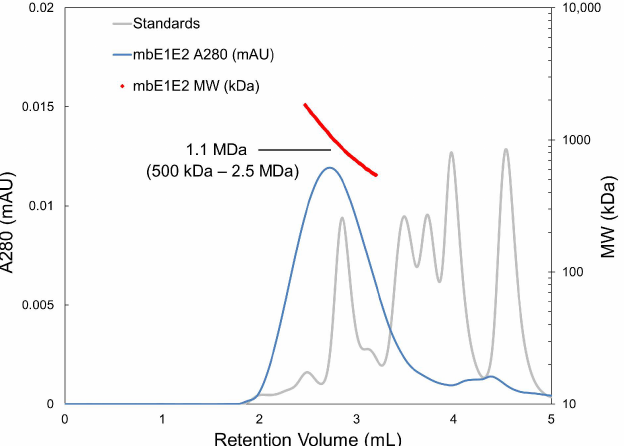
Figure 7. mbE1E2 characterized with SEC-MALS and compared with molecular weight standards. The SEC-MALS chromatograph of mbE1E2 is shown as a blue line. The range of elution volumes within the peak half-maximum is shown as red dots, with the size distribution labeled and enclosed in parentheses. An estimation of molecular weight at the center of the peak is indicated. Molecular weight standards are shown as a grey line corresponding to sizes of 670, 158, 44, 17, and 1.35 kDa. Reproduced with permission from